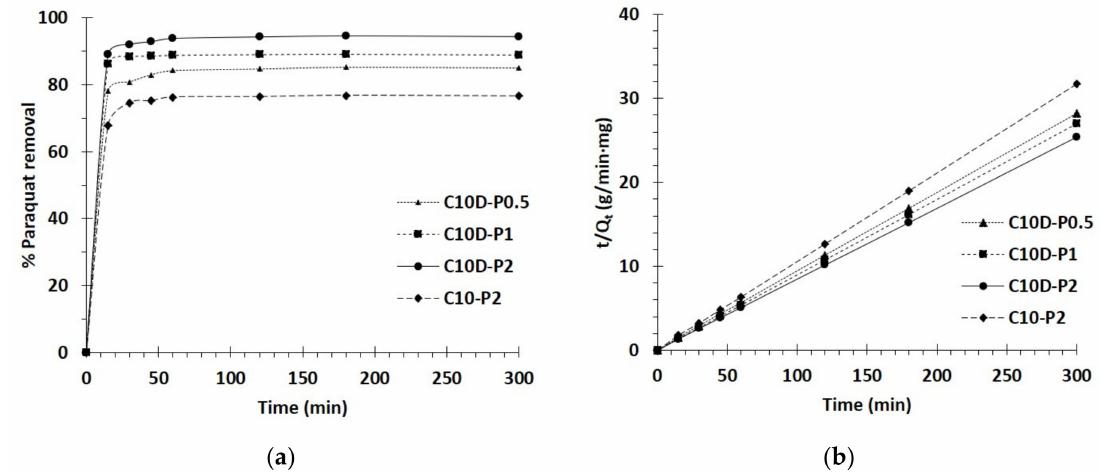
Figure 9. ( a ) Influence of contact time on adsorption capacity; ( b ) Pseudo second-order kinetics of PQ adsorption (conditions: 2 g/L of adsorbent dosage, 25 mg/L of PQ initial concentration, pH of 6.5, and temperature at 303 K).